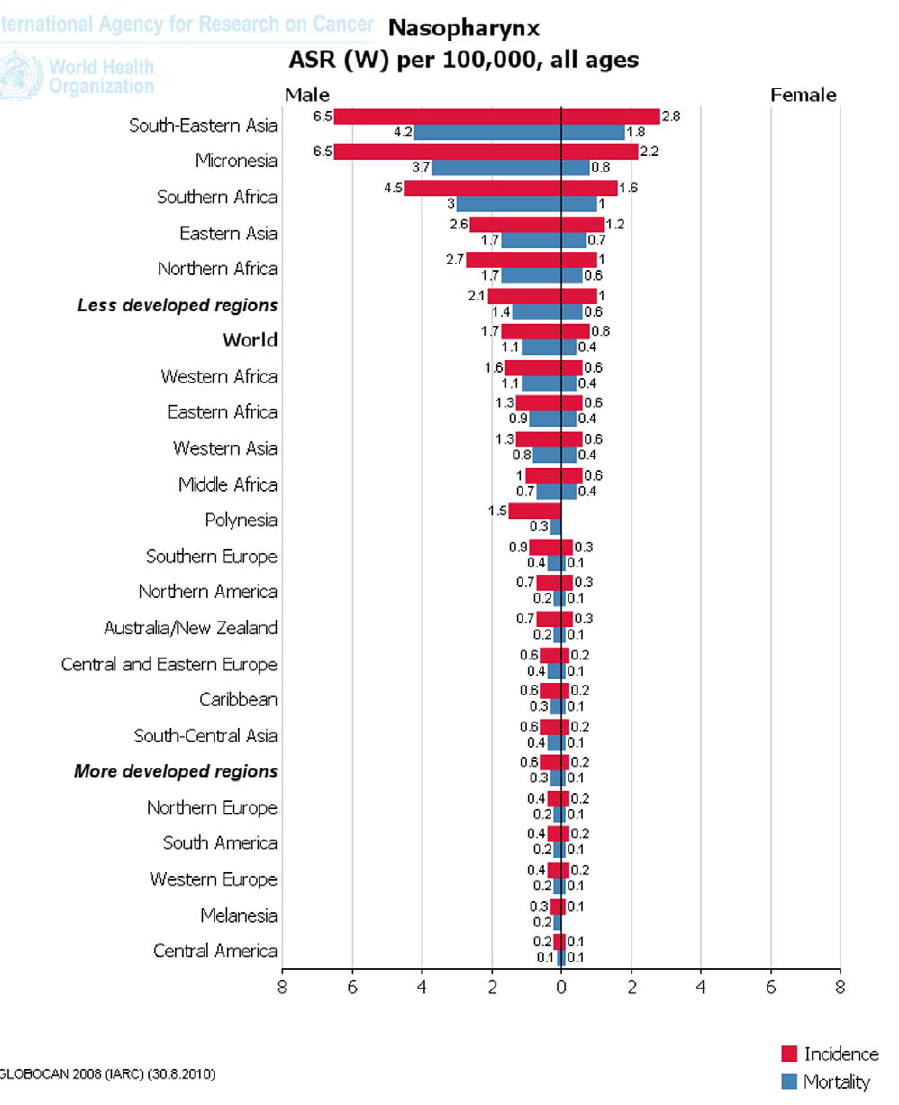
Figure 1. Continental incidence (red) and mortality (blue) of NPC demonstrated as ASR in 100,000 people-years from GLOBOCAN2008